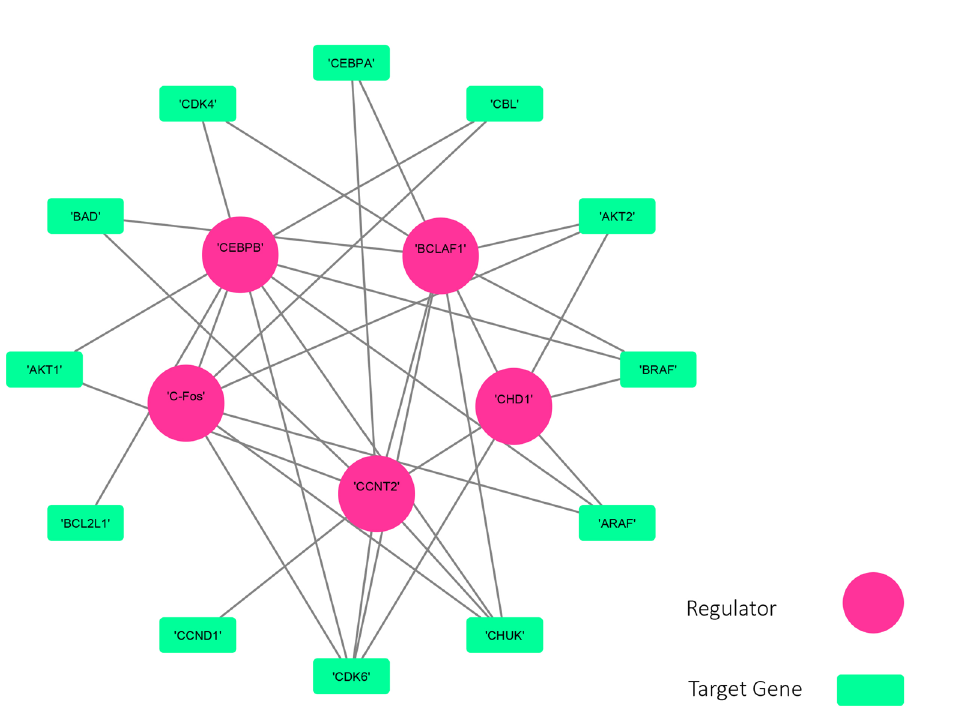
Figure 6. Subnetwork of GRN of AML that infer by